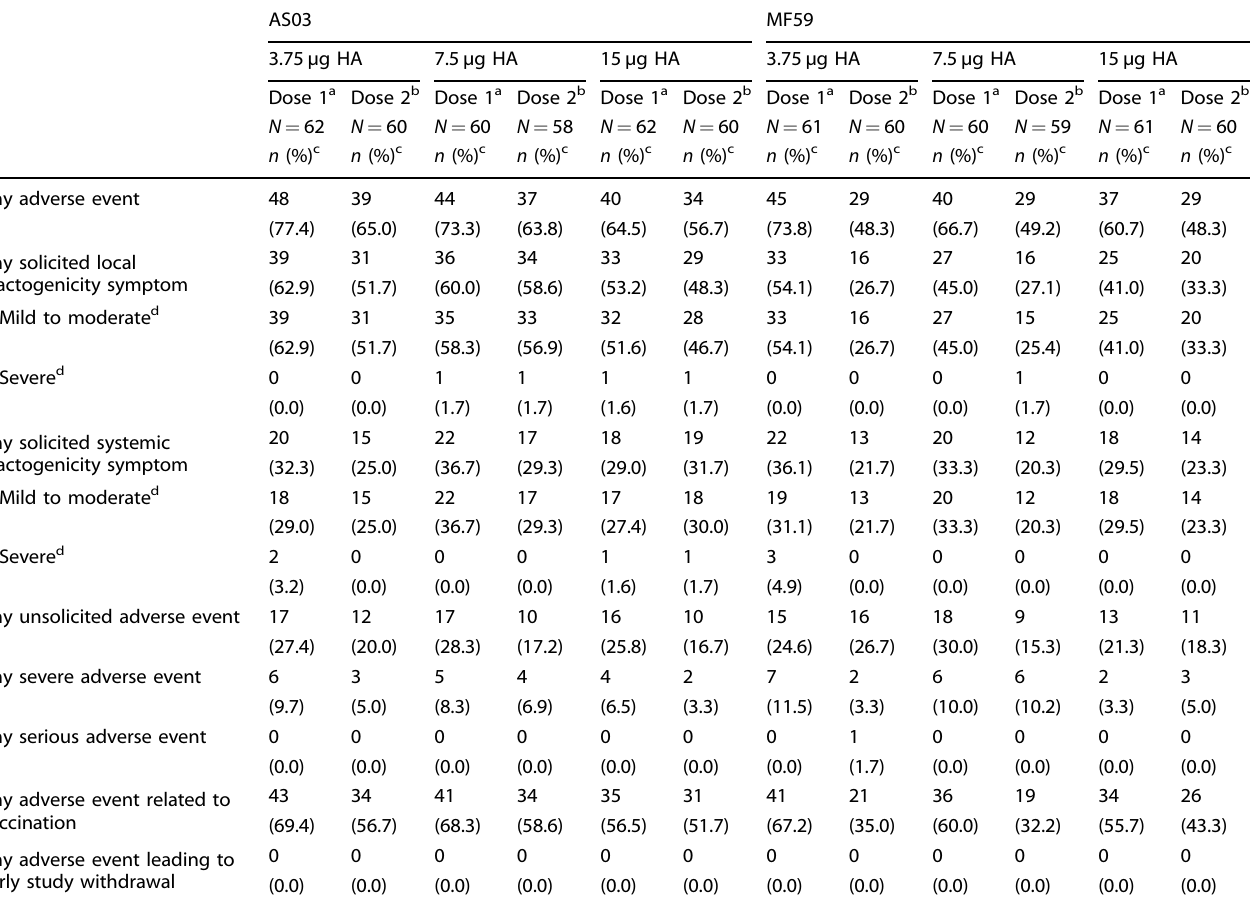
Table 2. Summary of all adverse events within the safety